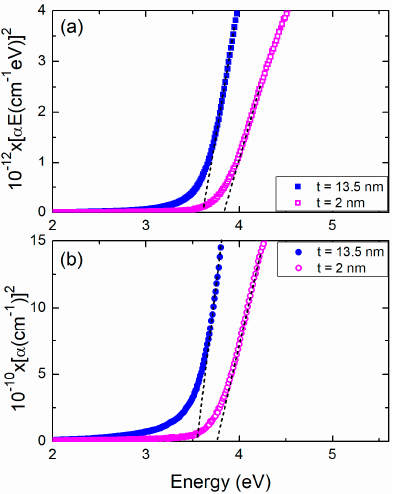
Figure 4. Tauc plots for two NiO films. ( a ) ( α E ) 2 as a function of photon energy Ε and ( b ) ( α ) 2 as a function of Ε . One can clearly observe a “blue” shift of E g determined with high precision by the extrapolation of a rather large linear part of the plots. The film thickness is indicated.